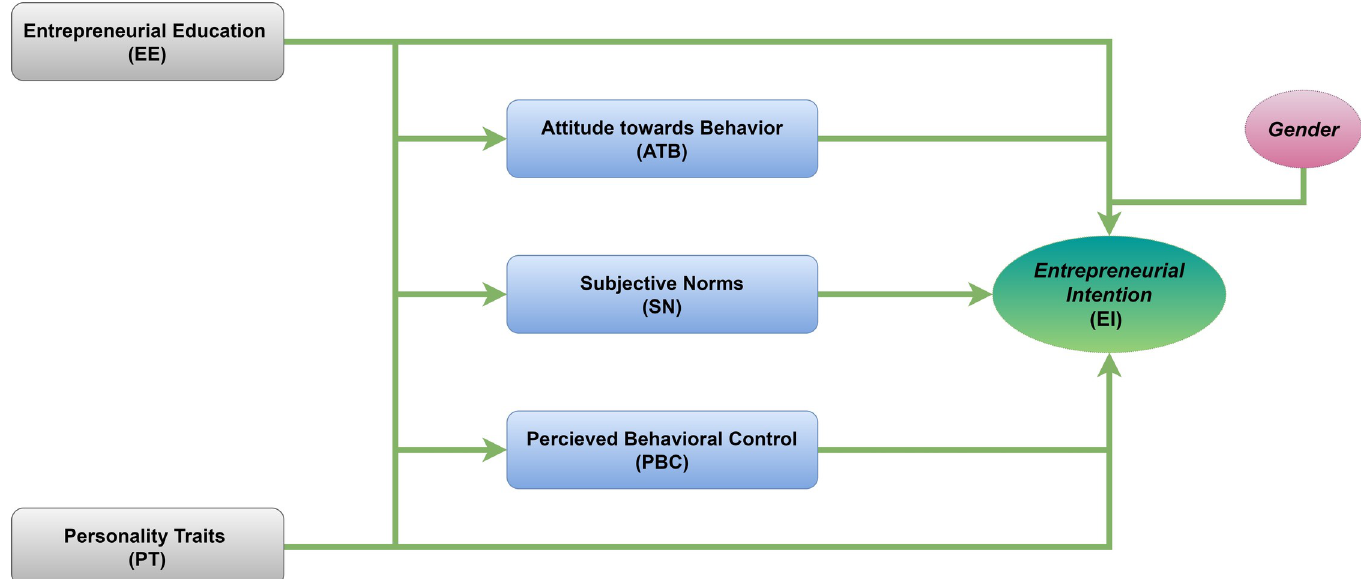
Fig 1. Study analytic framework extended theory of planned